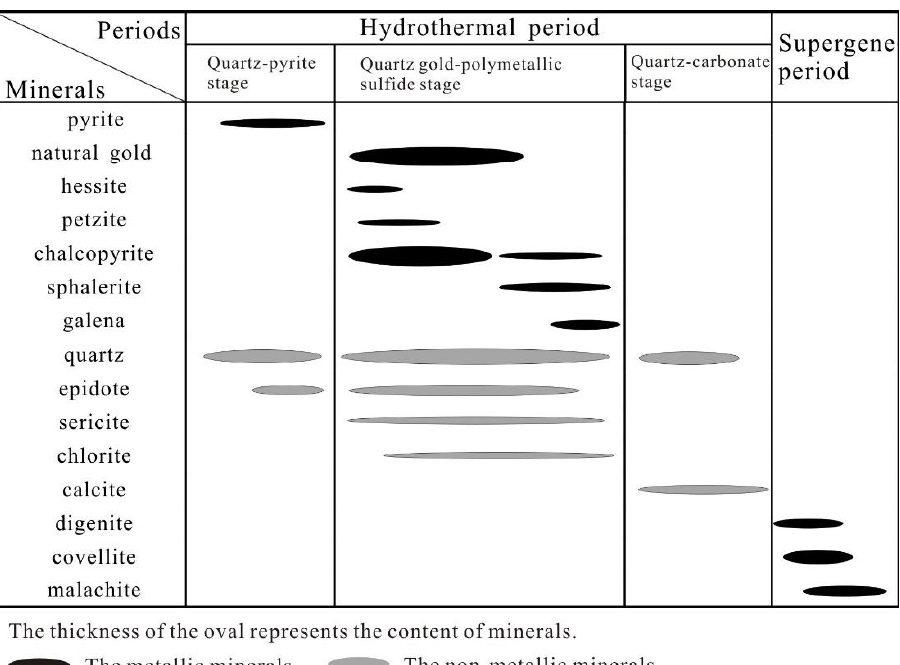
Figure 4. Paragenetic sequence of mineral deposition of the Toudaochuan gold deposit.